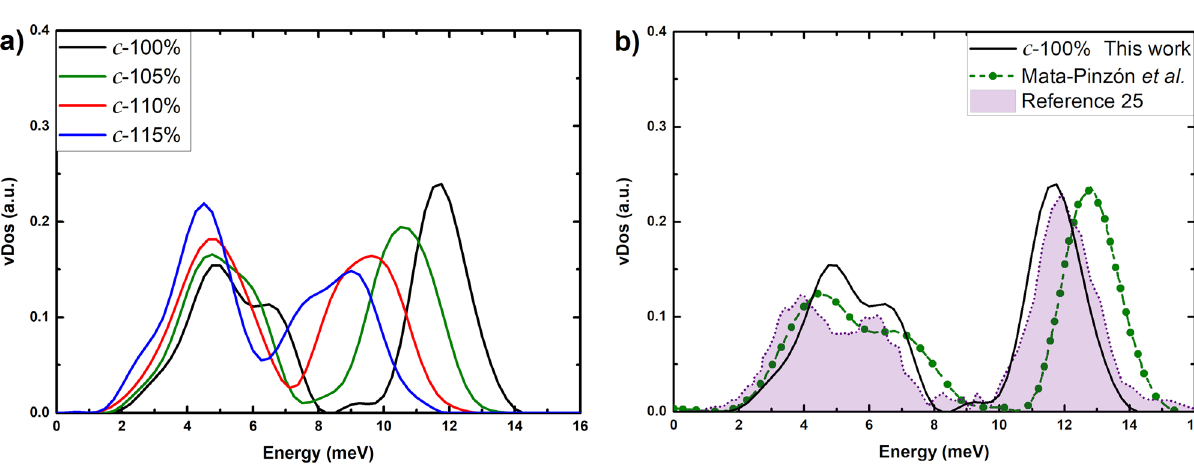
Figure 5. vDoS for ( a ) the non-expanded and expanded crystalline structures, and for ( b ) 100% c-Bi compared to the simulations of Ref. 10 and to the results of reference 25